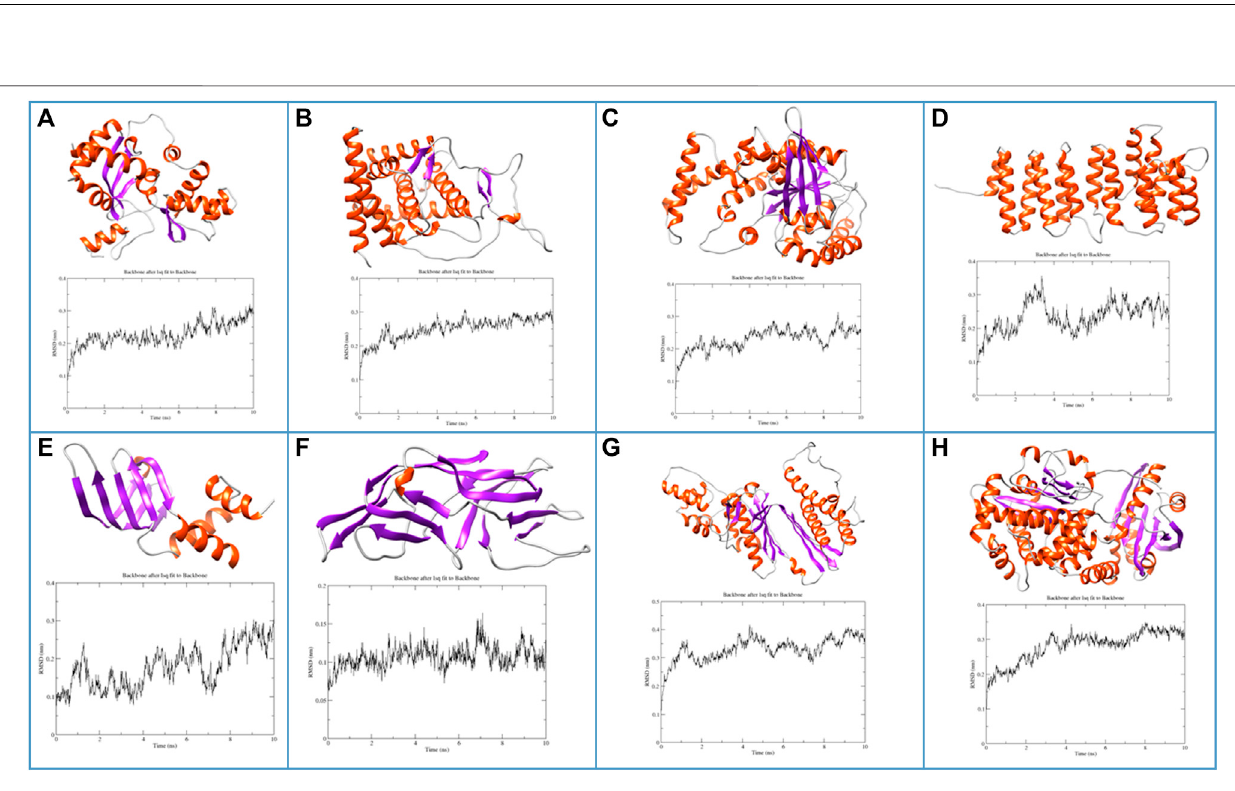
Frontiers in Genetics |